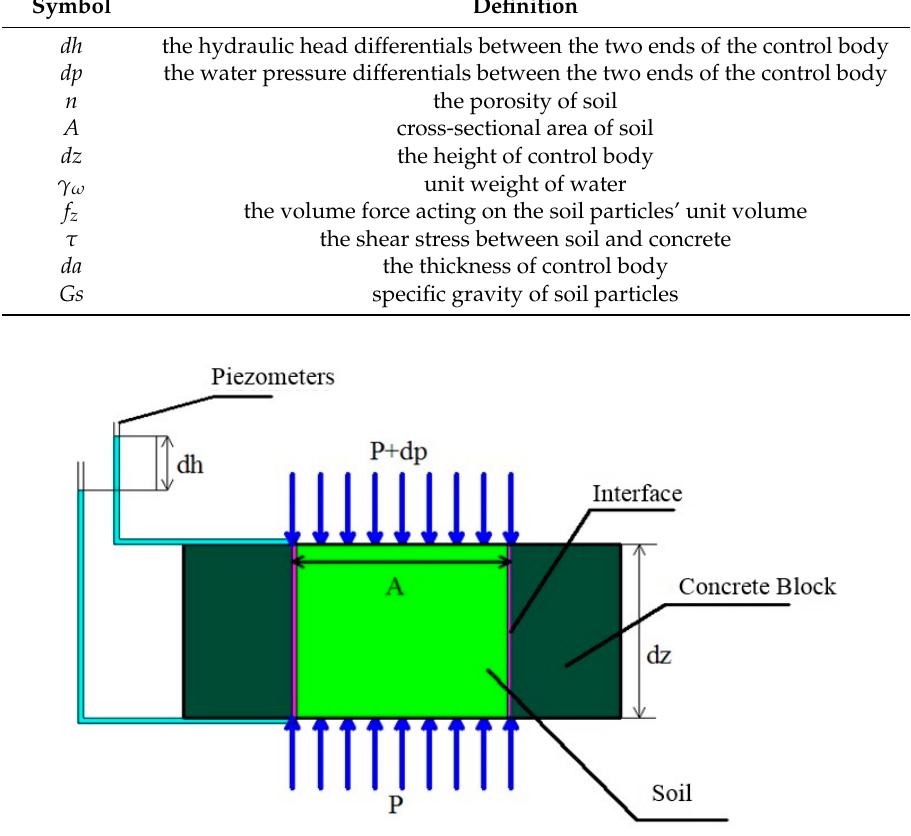
Figure 13. Forces acting on soil particles in the control body.